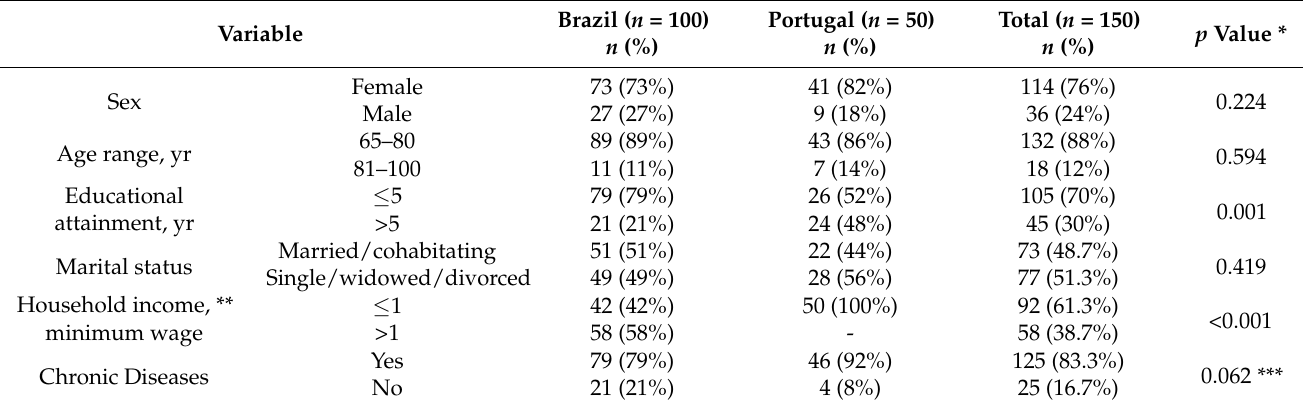
Table 1. Socioeconomic characteristics between Brazil and